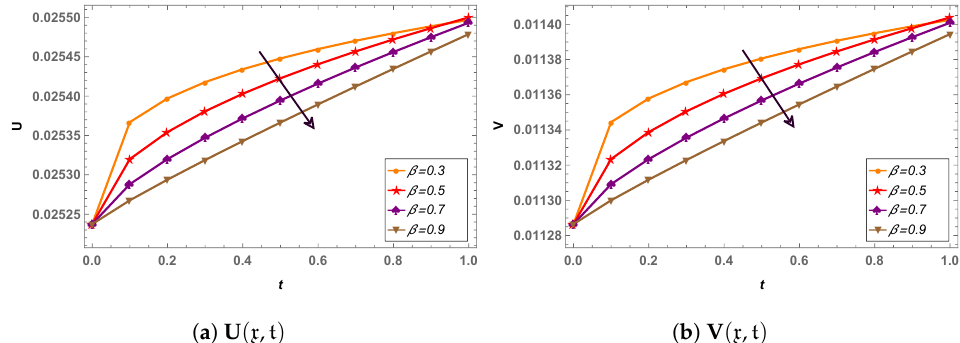
Figure 3. Two-dimensional (2D) plot of LHPM solutions at different β in Example 1, when x = 5, α = 1, η = 0.3 and a = 0.4.